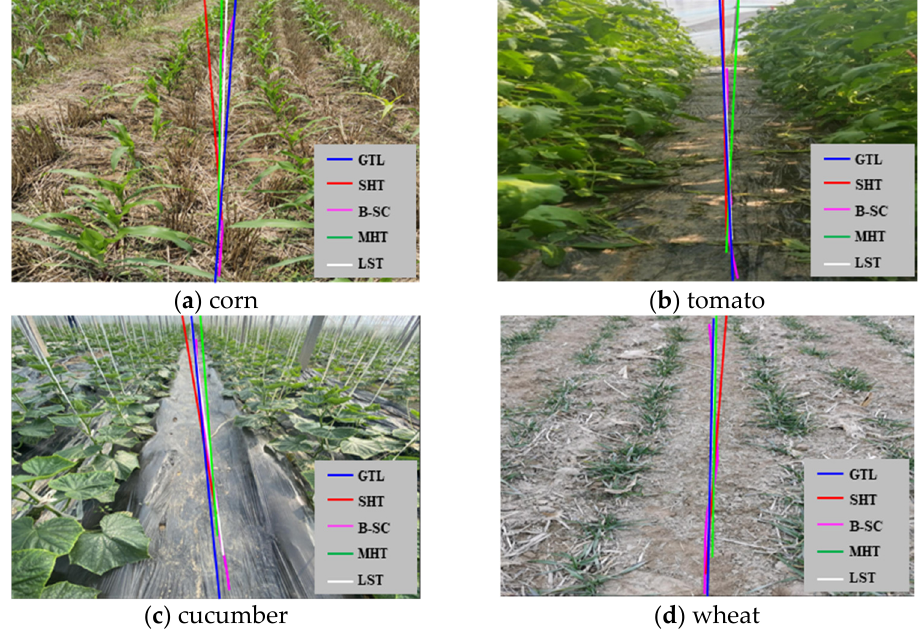
Figure 13. Comparison of line fittings. GTL stands for the ground-truth line. The ground-truth line indicates the line of evaluation. SHT stands for standard Hough transform. B-SC stands for B-spline curve. MHT stands for median-point Hough transform. LST stands for least squares method.